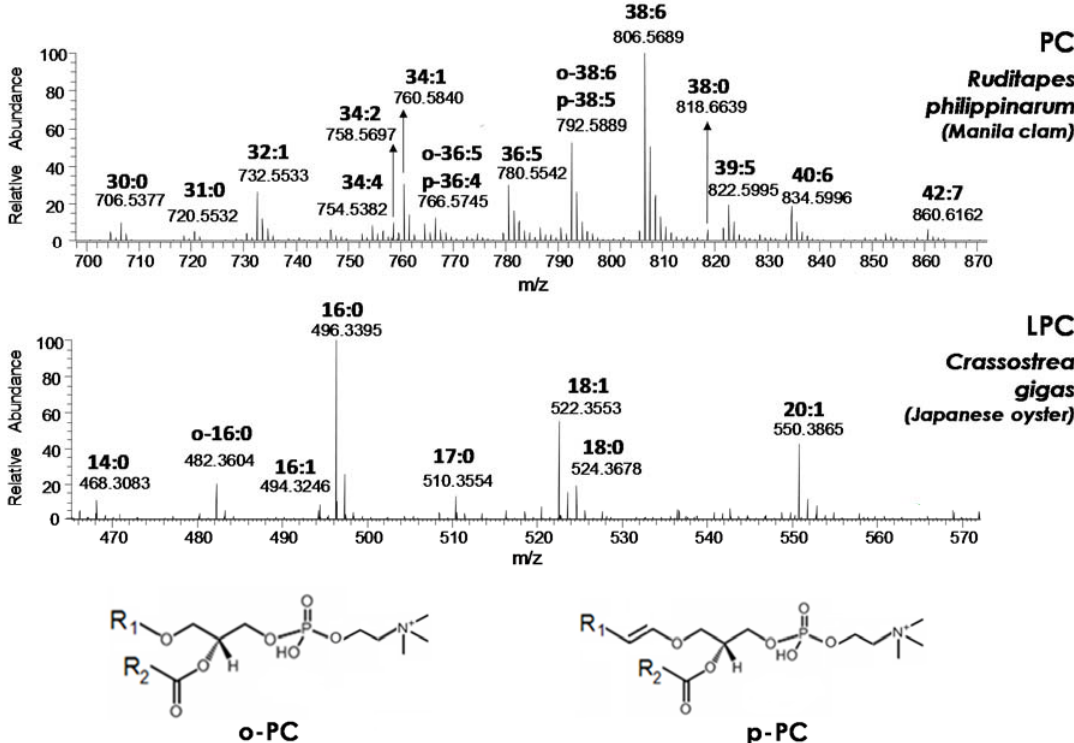
Figure 2. Averaged ESI(+)-FTMS spectra related to phosphatidylcholines (PC) and lysophosphatidylcholines (LPC) classes obtained, respectively, from the HILIC–ESI(+)-FTMS analysis of lipid extracts of Manila clams ( R. philippinarum ) and Japanese oysters ( C. gigas ). Spectral averaging was performed in the following retention time intervals: 7.3–11.6 min for PC and 14.6–16.7 min for LPC (see Figure 1). The molecular structures of plasmanyl-PC (o-PC) and plasmenyl-PC (p-PC) are also reported.